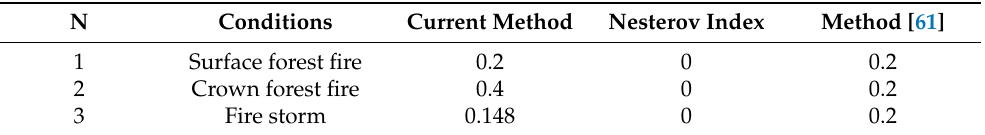
Table 4. Comparative analysis of various methods for predicting the probability of a forest fire from a